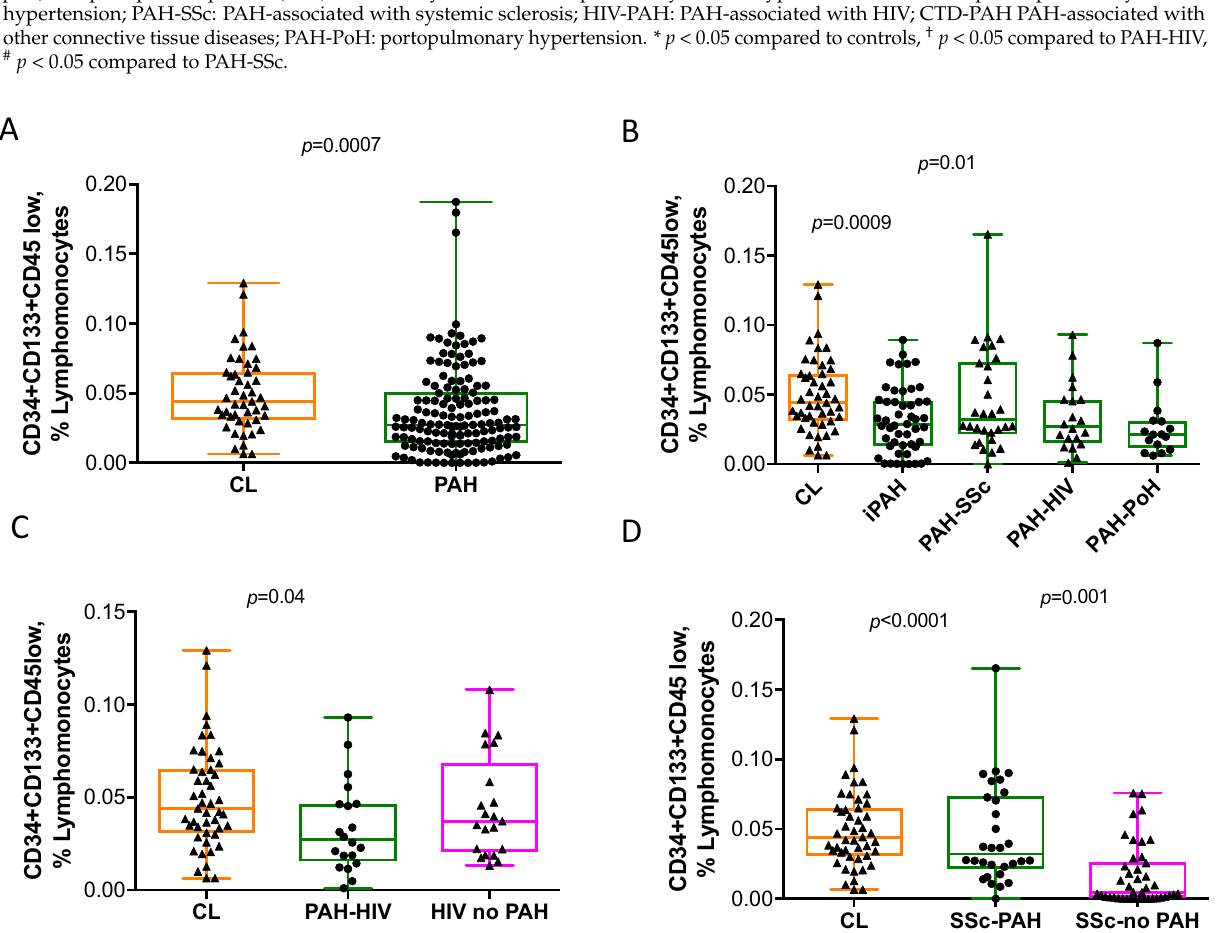
Figure 2. Percentage of circulating progenitor cells (PCs) in pulmonary arterial hypertension, scleroderma and HIV infection and healthy controls. Percentage of ( A ) CD34 + CD133 + CD45 low labelled cells, expressed as percent of lymphomonocytes, in pulmonary arterial hypertension (PAH) versus healthy controls; ( B ) percentage of CD34 + CD133 + CD45 low labelled cells in all the different PAH subtypes versus healthy controls; ( C ) Percentage of CD34 + CD133 + CD45 low labelled cells in patients with HIV infection, with or without associated PAH; ( D ) percentage of CD34 + CD133 + CD45 low labelled cells in patients with scleroderma, with or without associated PAH. The whiskers extend from the minimum to maximum points. Mann Whitney Rank Sum test and Kruskal-Wallis One Way Analysis of Variance and when significant, post-hoc Dunn’s multiple comparisons test.